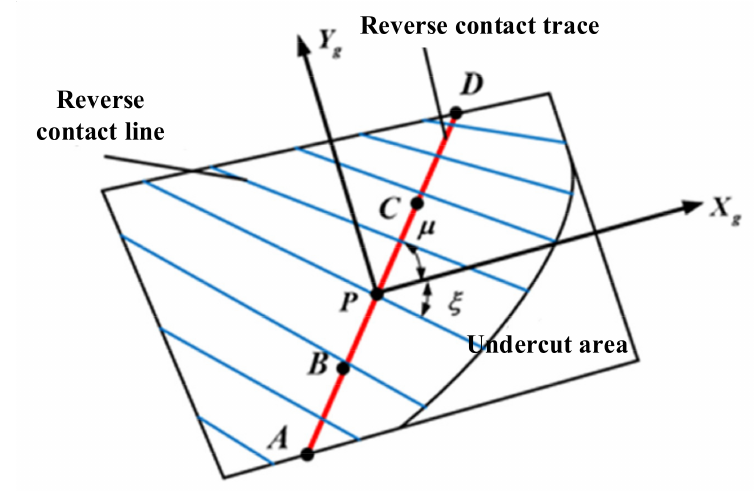
Figure 5. Face gear tooth surface projection.